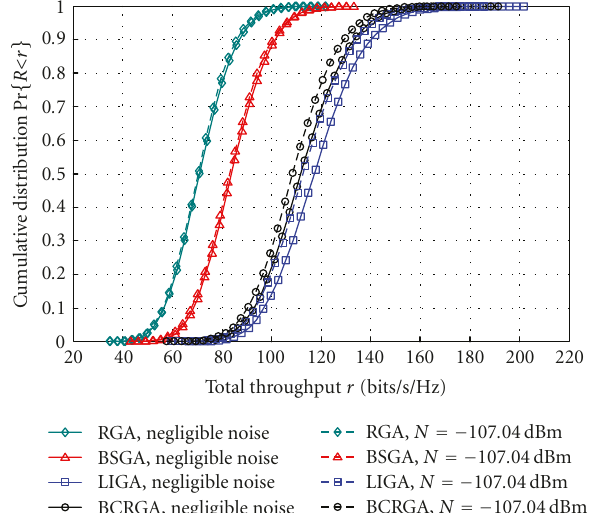
Figure 5: Cumulative probability distribution of total throughput per cell without code limitation constraints on the number of users per assignment group ( K = 64 users/cell and WFPA in use).